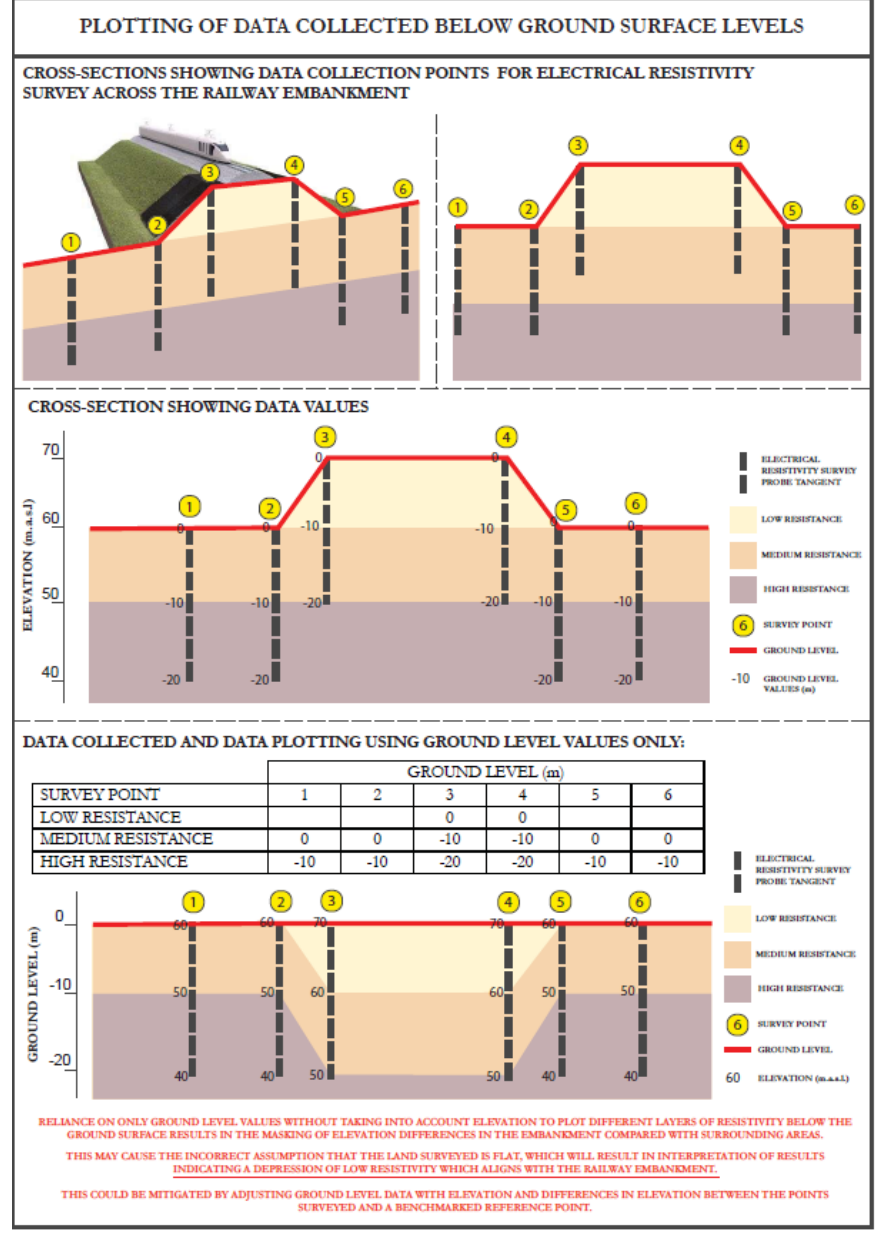
Figure 13. Explanation of apparent depressions below ground surface level, when embankment profile is ignored.